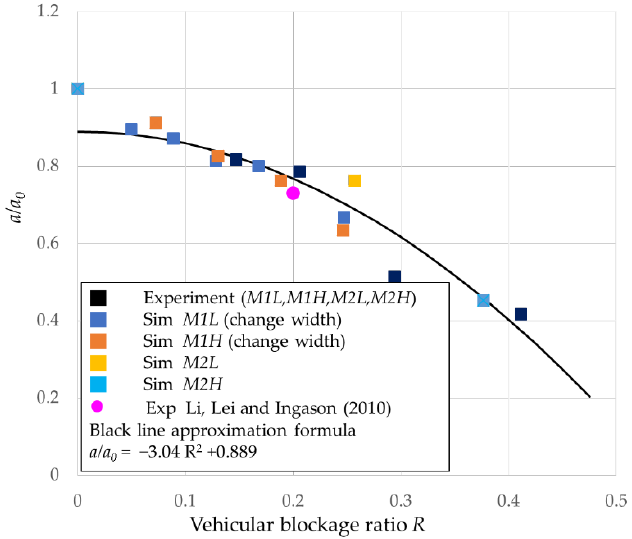
Figure 16. Approximation formula of a / a0 for Pattern A.